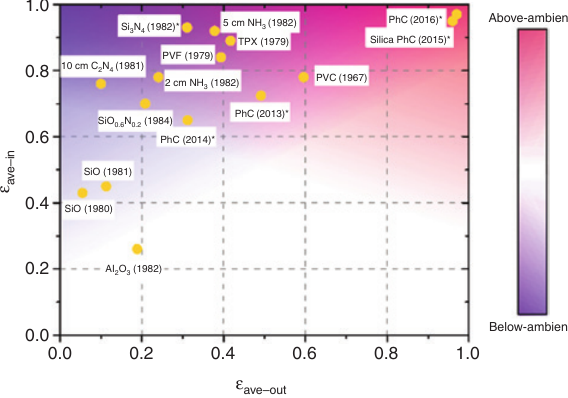
Figure 7: Cooling parameters of selective radiative coolers. The top-left corner (blue shaded region) implies the best below-ambient cooling performance. The top-right corner (red shaded region) implies the best above-ambient cooling performance. Data